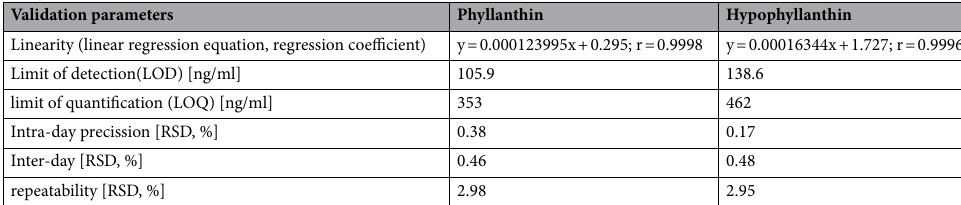
Table 2. The validation data for the determination of phyllanthin and hypophyllanthin by elaborated HPLC– UV method.